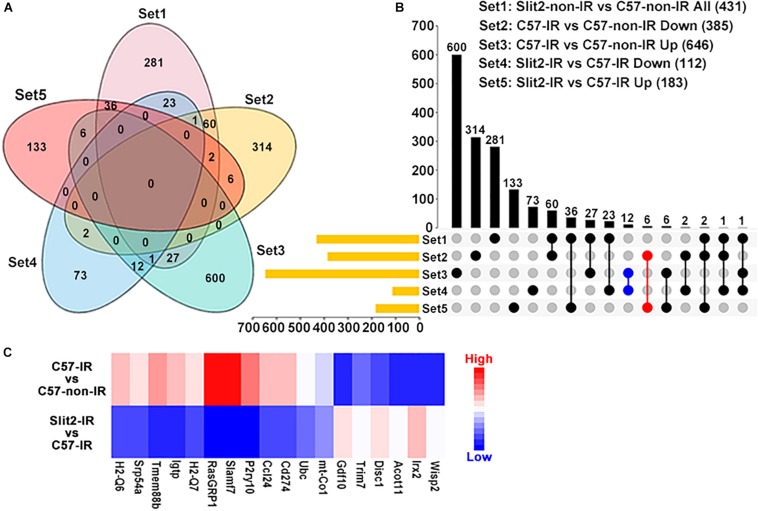
Gene expression profiles of C57BL/6J and Slit2-Tg hearts subjected or not subjected to ischemia–reperfusion (IR) (n = 3 per group), as determined by RNA sequencing analysis. (A) Venn diagram of the differentially expressed genes (DEGs) in all comparisons, including all DEGs in the Slit2-non-IR vs. C57-non-IR comparison (pink), the upregulated DEGs in the C57-IR vs. C57-non-IR comparison (green), the downregulated DEGs in the C57-IR vs. C57-non-IR comparison (orange), the upregulated DEGs in the Slit2-IR vs. C57-IR comparison (red), and the downregulated DEGs in the Slit2-IR vs. C57-IR comparison (blue). (B) UpSet plot displaying the number of DEGs between groups for each intersection. The blue dots represent the genes (12) at the intersection between the downregulated DEGs in the Slit2-IR vs. C57-IR comparison and the upregulated DEGs in the C57-IR vs. C57-non-IR comparison, and the red dots represent the genes (6) at the intersection between the upregulated DEGs in the Slit2-IR vs. C57-IR comparison and the downregulated DEGs in the C57-IR vs. C57-non-IR comparison; both exclude overlap with all DEGs in the Slit2-non-IR vs. C57-non-IR comparison. (C) Heatmap displaying the fold changes in 18 genes obtained from the Venn diagram analysis. DEGs with log2 (fold change) values > 0 are indicated in red, and those with log2 (fold change) values < 0 are indicated in blue; a darker color indicates a higher P-value.